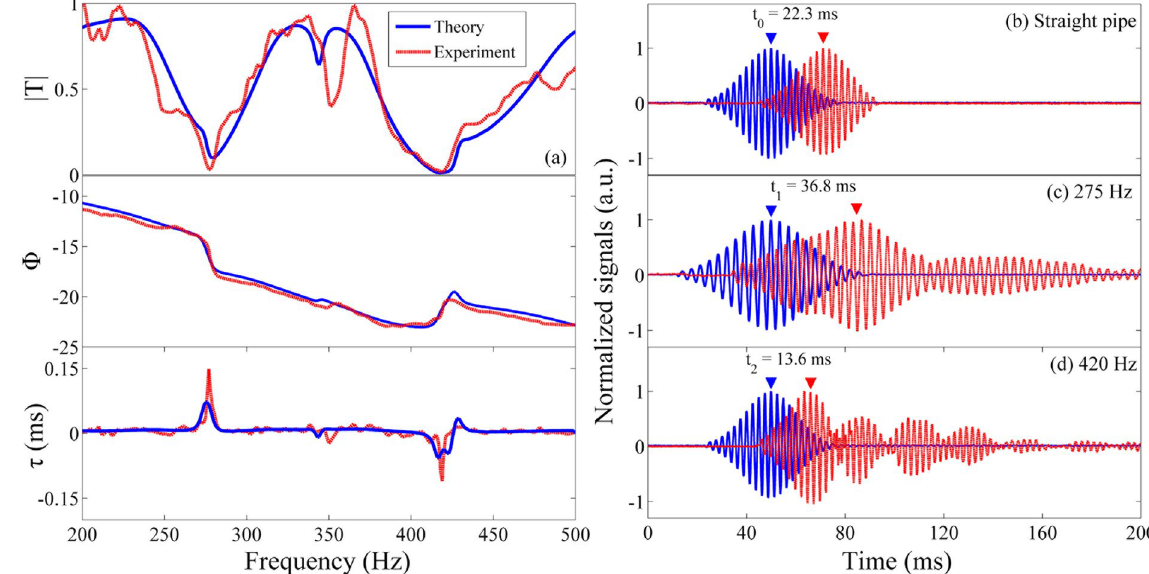
Figure 3. Theoretical and experimental results. ( a ) The theoretical (solid line) and experimental (dashed line) transmission amplitudes, phases and phase times. The theoretical and experimental results are both obtained on the basis of the parameters in the QKCM shown in Fig. 1b. ( b ) Measured acoustic pulses in a straight waveguide with the same length as the QKCM as a gauge to evaluate the group velocity. ( c ) and ( d ) Measured signals in the QKCM using the exciting of Gaussian pulses with the central frequencies of 275 Hz and 420 Hz, respectively. The solid line (blue) indicates the signal measured by the accelerator attached on the loudspeaker diaphragm and the dashed line (red) indicates the signal detected by the microphone set up at the hard